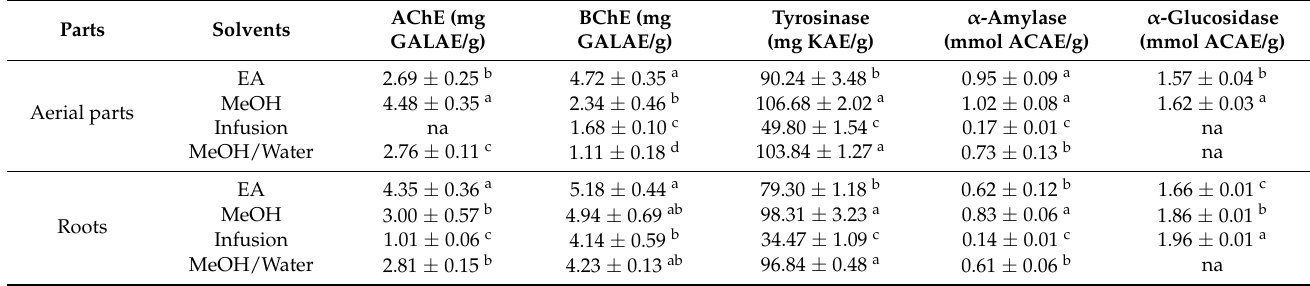
Table 6. Enzyme inhibitory properties of Epilobium hirsutum